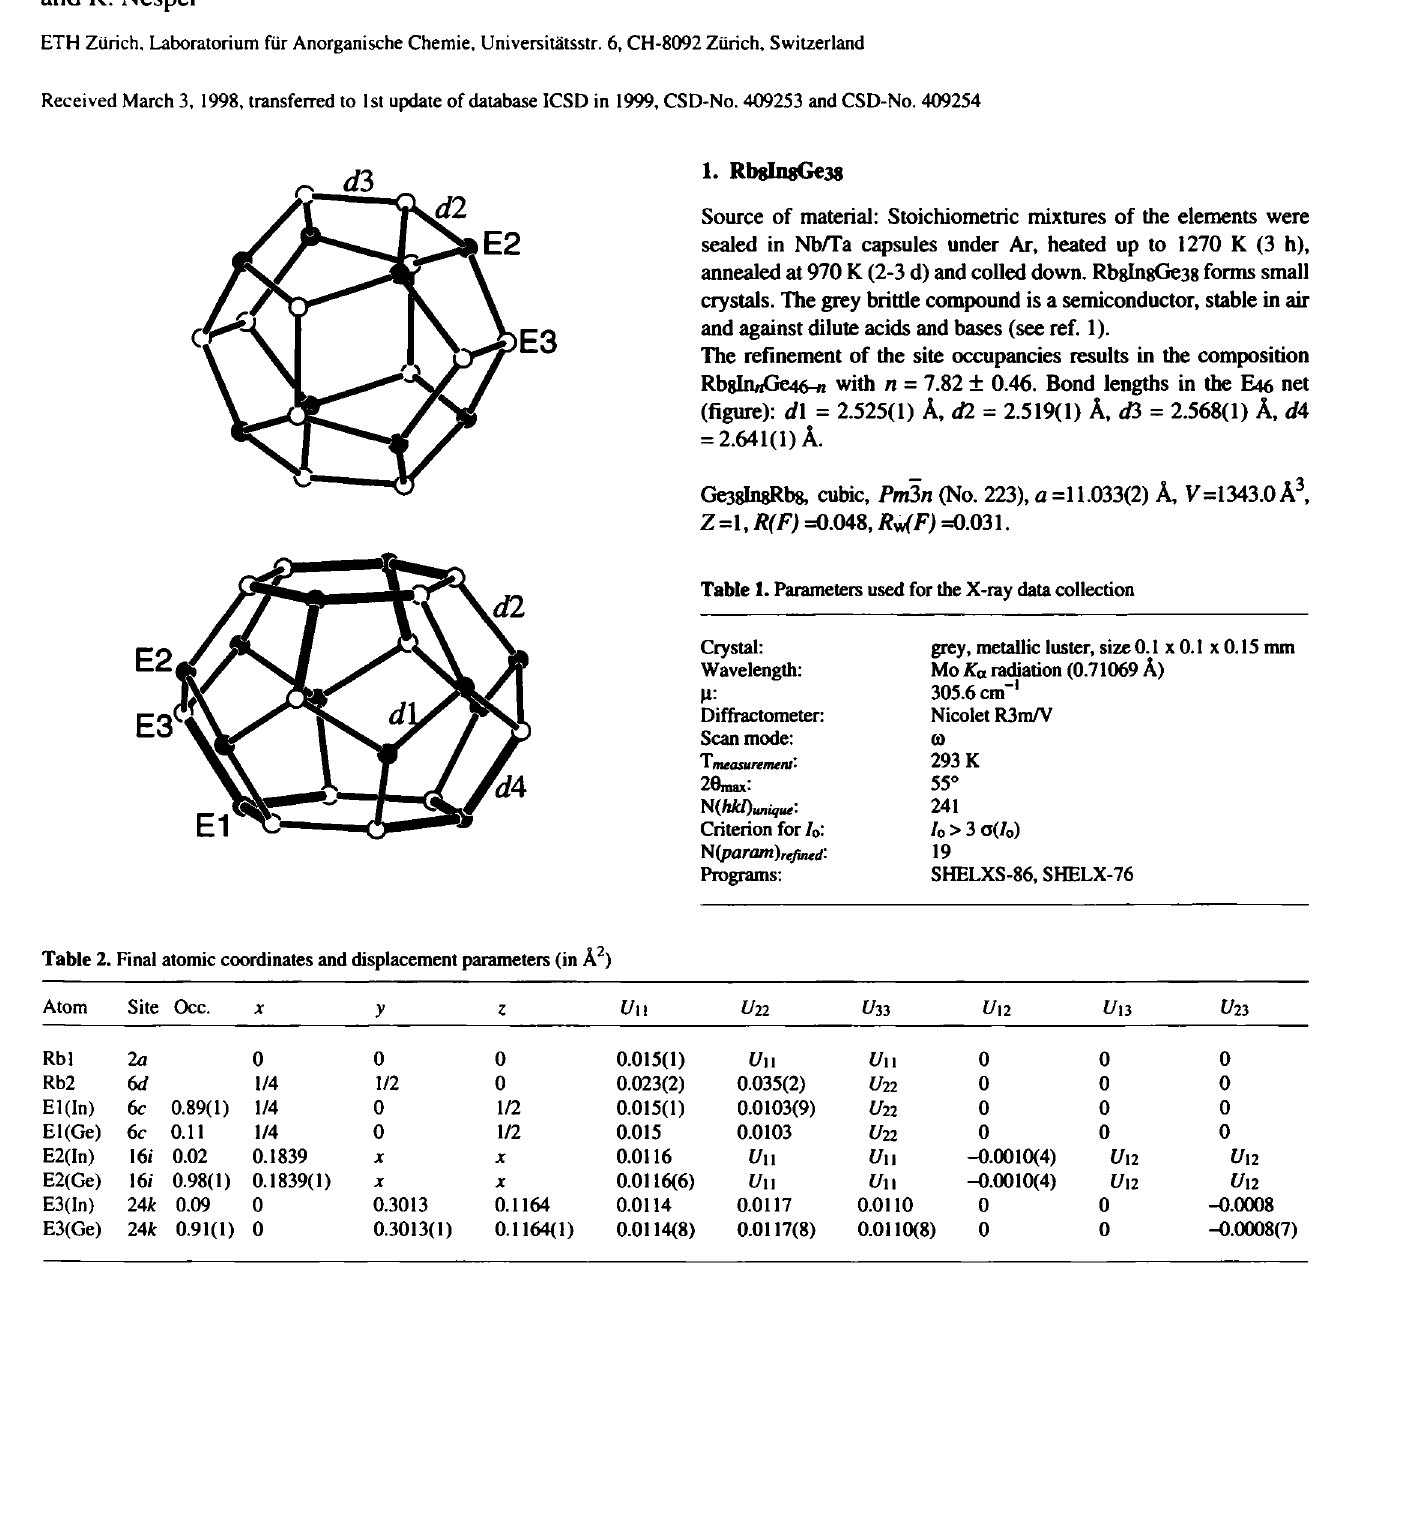
annealed at 970 К (2-3 d) and coUed down. RbglnsGess forms small crystals. The grey brittle compound is a semiconductor, stable in air and against dilute acids and bases (see ref. 1). The refínement of the site occupancies results in the composition Rb8lnnGe46-n with η = 7.82 ± 0.46. Bond lengths in the E46 net (figure): d\ = 2.525(1) Â, d2 = 2.519(1) k, dì = 2.568(1) Â, dA = 2.641(1) Â.